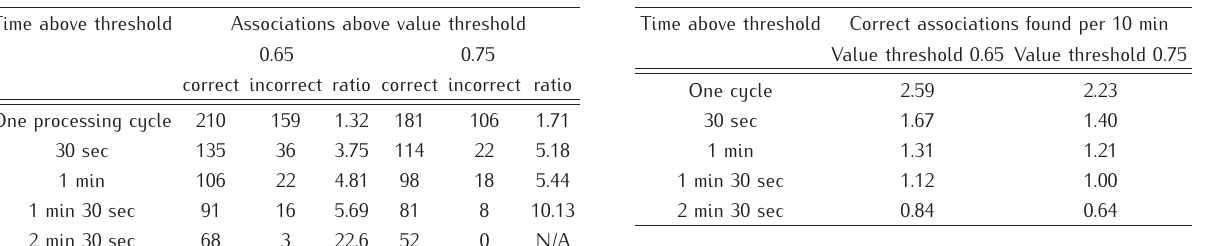
Table 2. Total number of correct and incorrect associations found. Table 3. Total number of correct associations found in 10